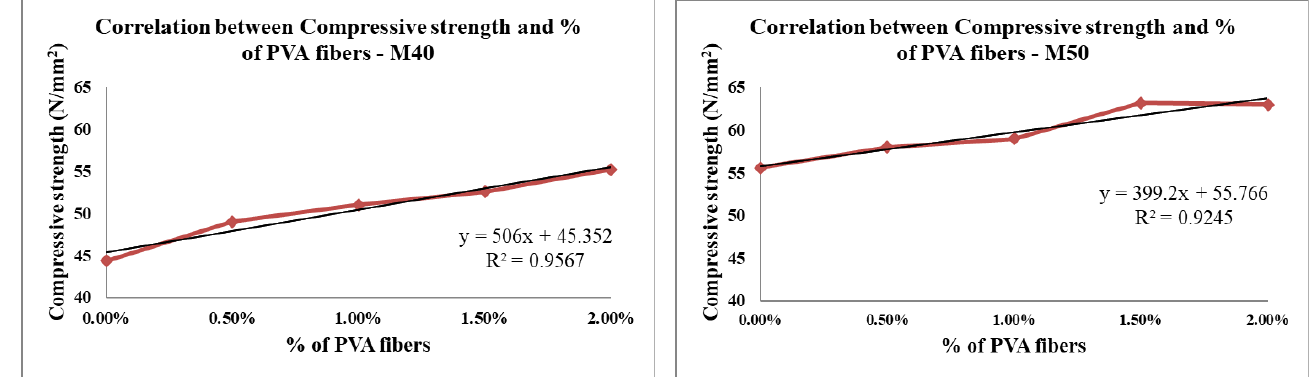
Figure 10. Graph showing correlation between the strength of concrete and the proportion of PVA fibers.